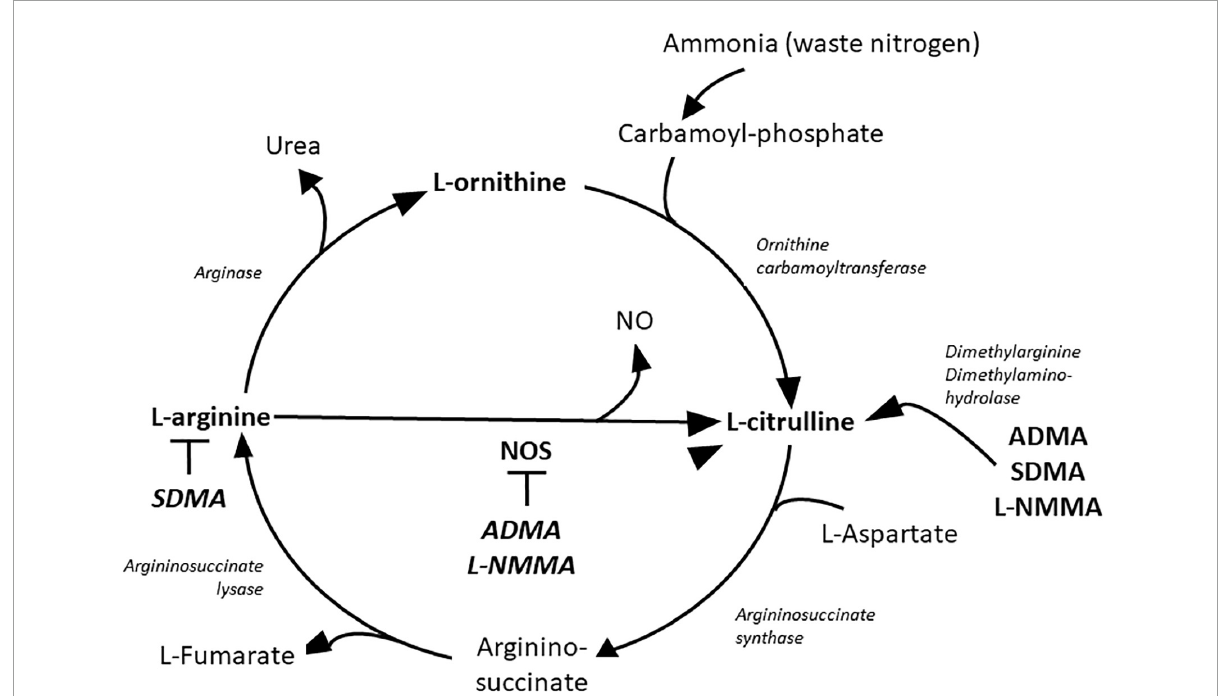
FIGURE1 Metabolites of the urea cycle. ADMA, asymmetric dimethylarginine; L-NMMA, L-N-monomethyl-arginine; NO, nitric oxide; NOS, nitric oxide synthase; SDMA, symmetric dimethylarginine.